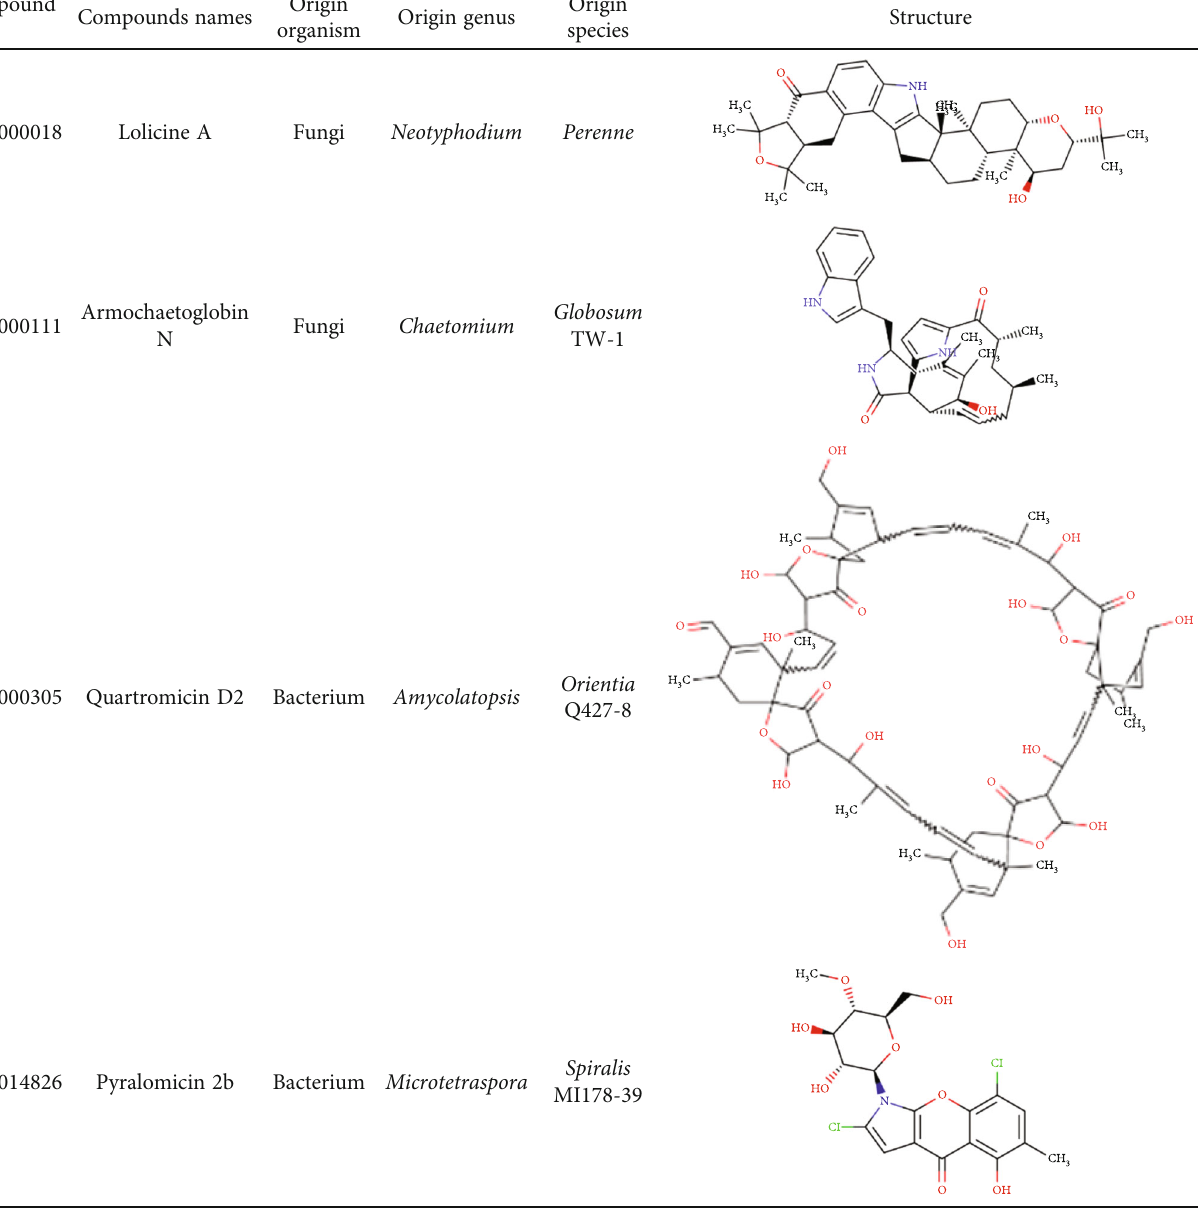
Table 1: The complete detail of the shortlisted